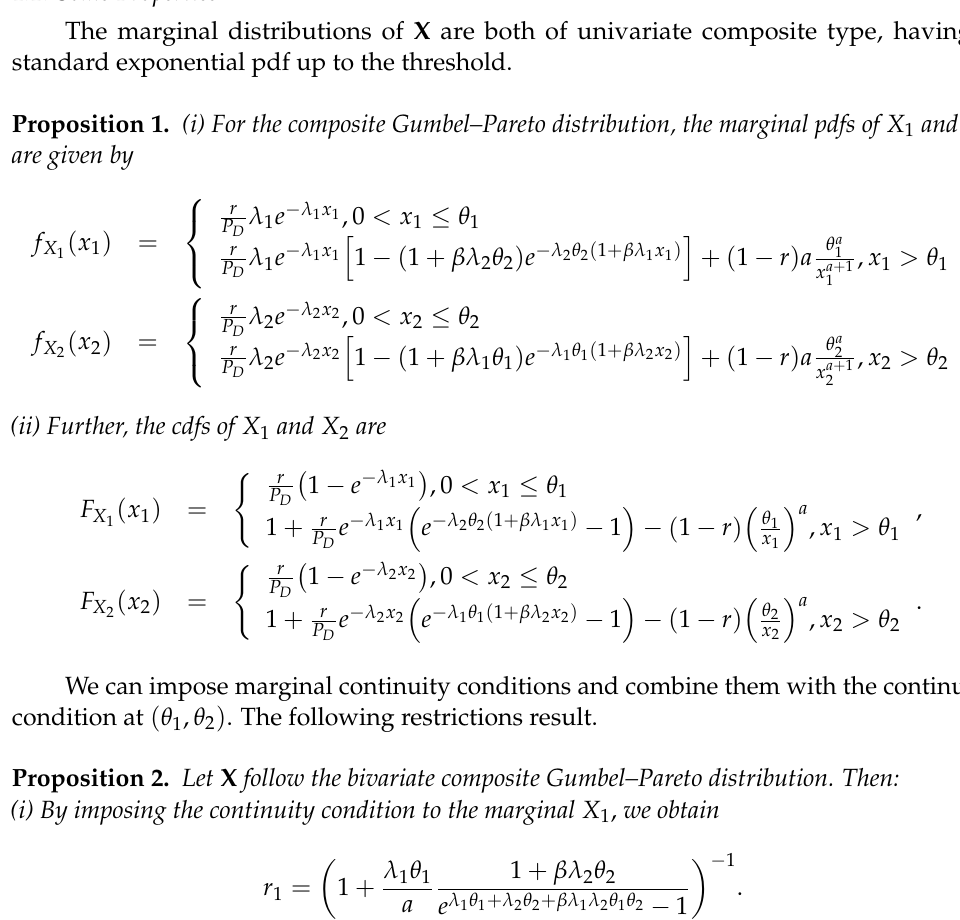
solid line, f X dashed 2 1